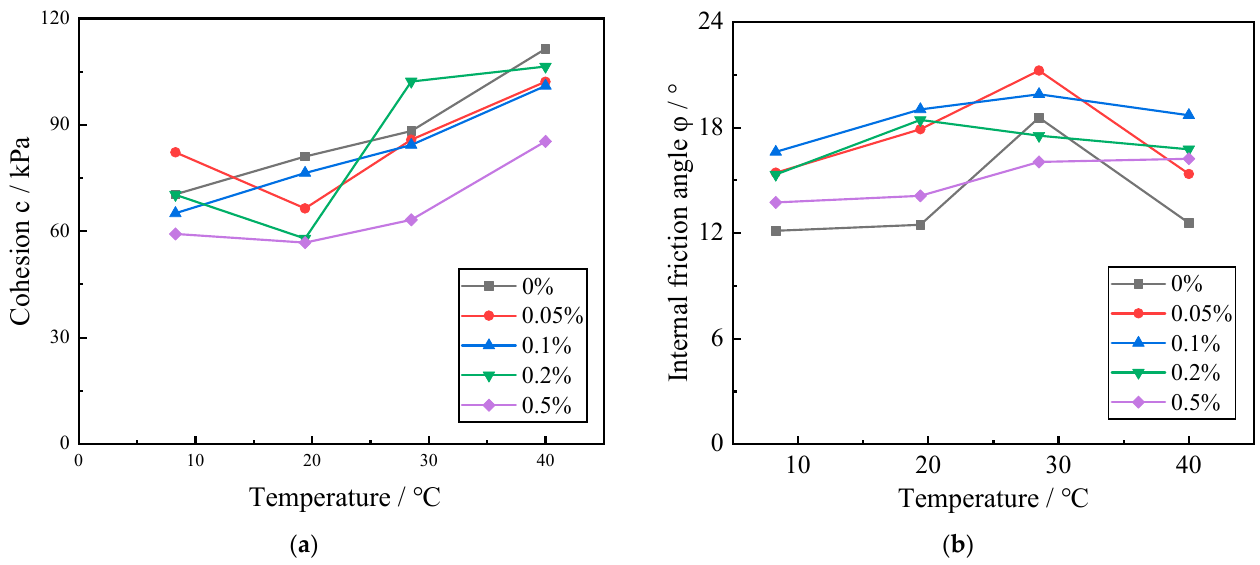
Figure 7. Curve of influence of temperature on the shear strength index of red clay. ( a ) The graph of the change of cohesion force with temperature; ( b ) The graph of internal friction angle with tem- perature